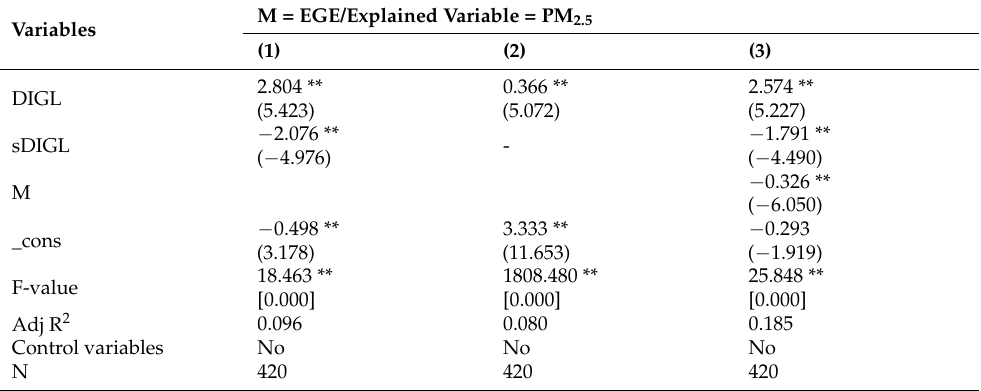
Table 7. Results of the analysis of EGE as a mediating effect.